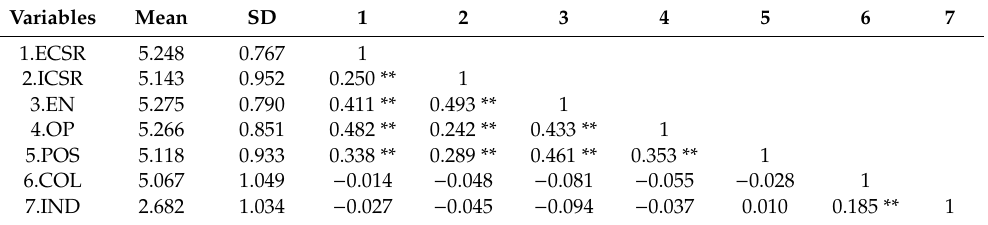
Table 2. Descriptive statistics, mean, standard deviation, and